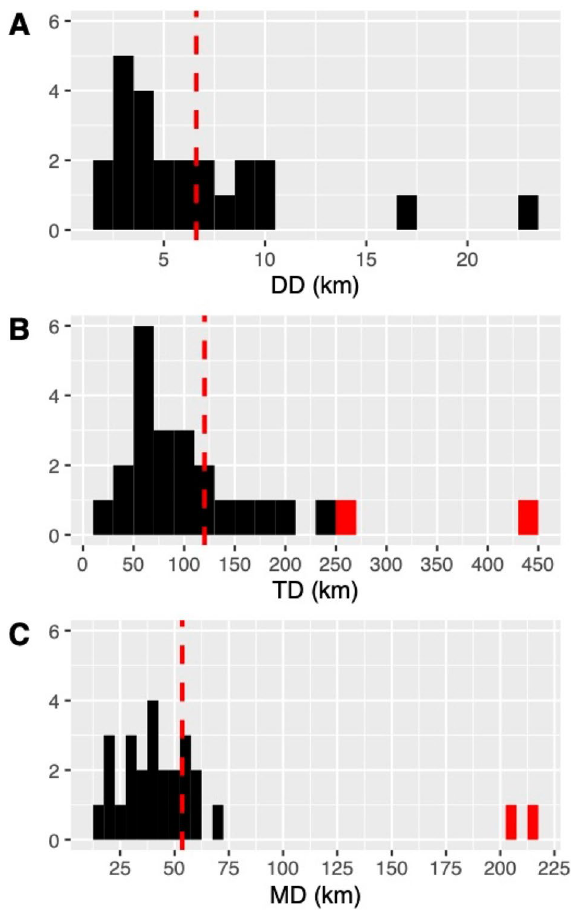
Figure 3. Long-range exploratory capacity results: ( A ) daily distance covered; ( B ) total distance covered; and ( C ) maximum distance covered. Means are represented by red dashed lines. Red bars represent individual